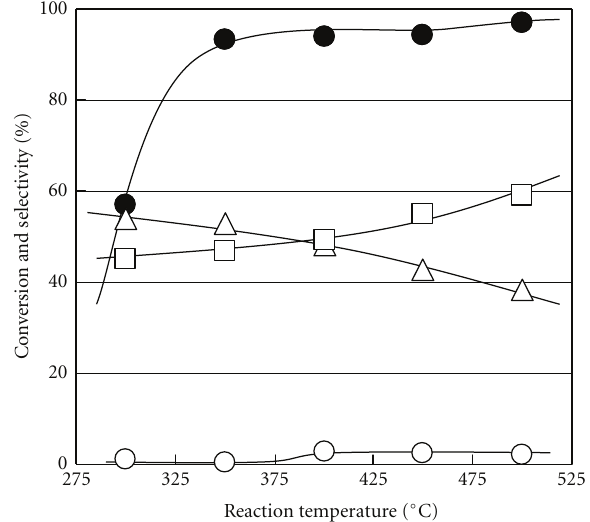
Figure 7: Conversion and product selectivity of catalytic cracking of hydrotreated oil over ns Al 2 O 3 /USY catalyst depending on reaction temperature. (cid:2) : Conversion; selectivity: (cid:4) : normal para ffi ns; isopara ffi ns; (cid:2) : olefins.